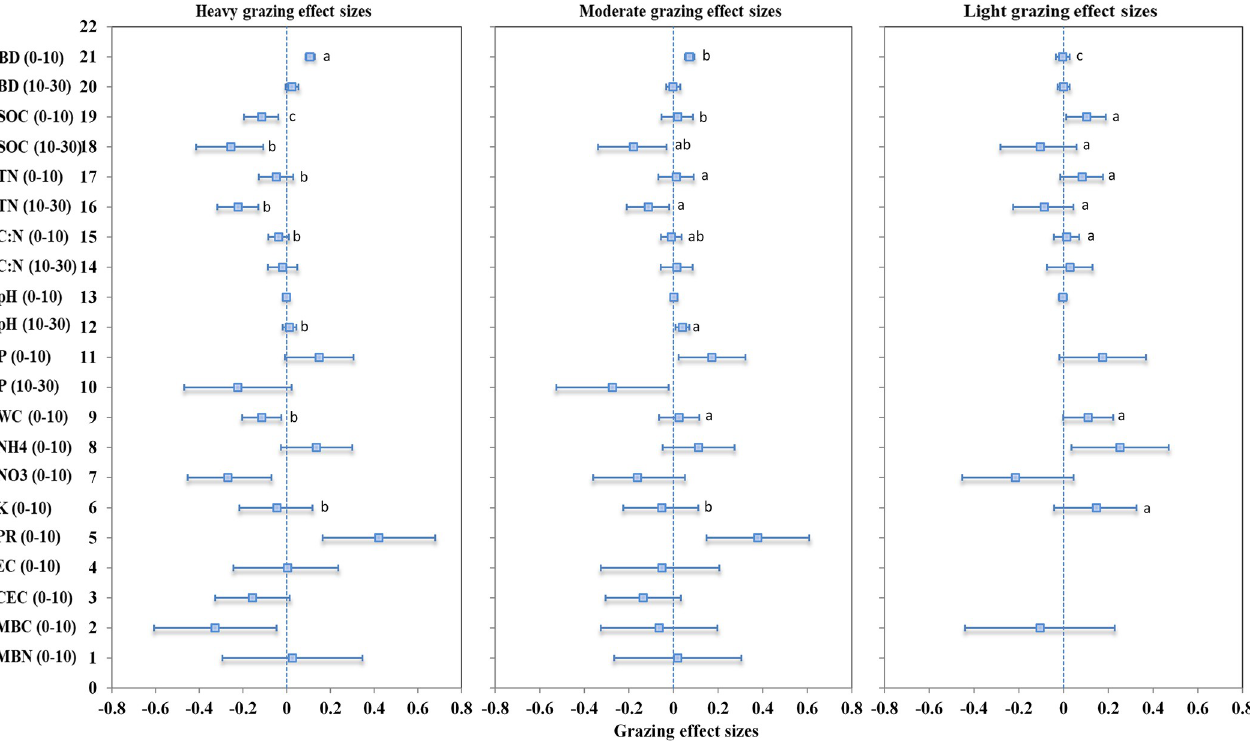
Fig 3. Global grazing effect sizes of 15 soil properties under 3 grazing intensities at 2 soil depths. Bars represent the means and their ranges of 90% confidence intervals (CIs). The vertical dashed line was drawn at the grazing effect size = 0. Means within the same row followed by different small letters are significantly different at P < 0.10 for the grazing